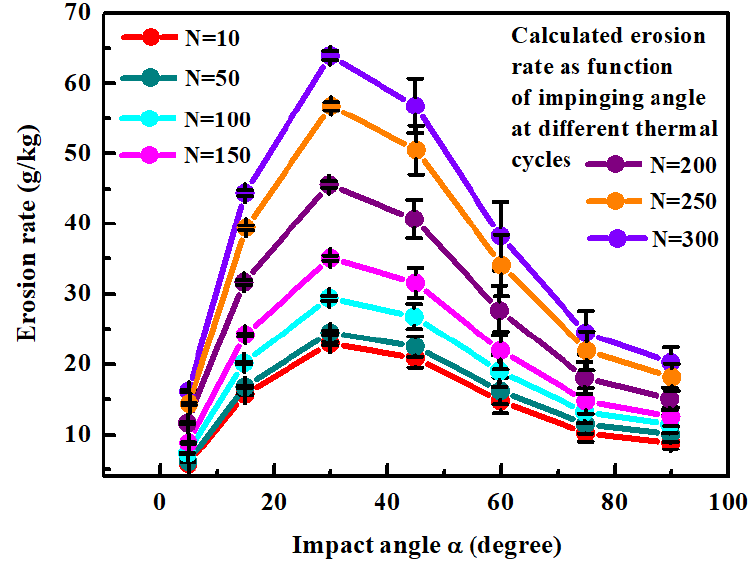
Figure 16. The calculated erosion rate versus impact angle α at selected thermal cycles.